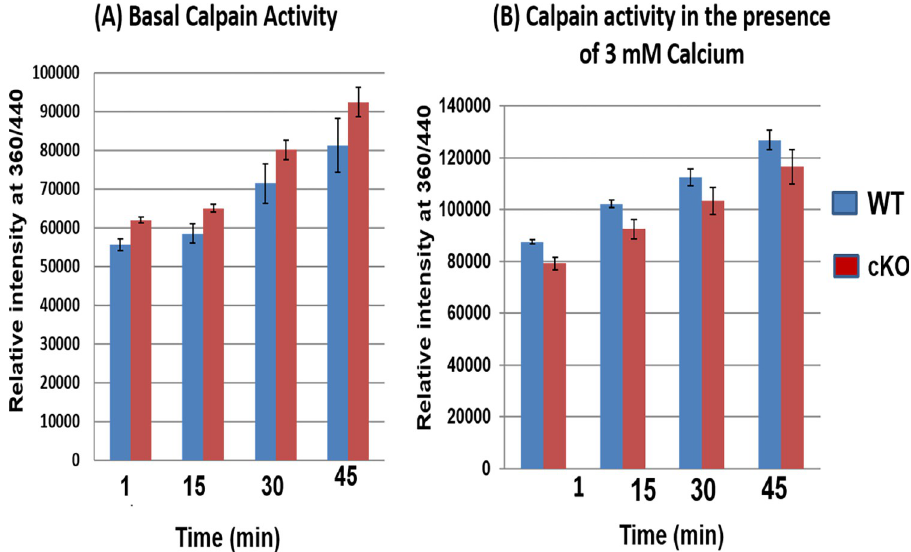
Interestingly, in addition to β -tubulin, fragments of calpain-3 were observed only in 5000 rpm spun-pellet fraction of cKO lenses but not in WT- and β A3HET-lenses Table 3. Earlier studies have shown that calpain being associated with cataract development. To further characterize calpain-3 activity in β A3cKO lenses, an in vitro calpain activity assay was carried out using N- total protein homogenates from 1-month-old WT- and β A3cKO-lenses were incubated with the substrate in the absence of calcium (representing the basal activity of calpain) and in the presence of 3 mM calcium (representing Ca 2+ -induced calpain activation), and the release of products was monitored at 15 min intervals up to 45 min. The β A3cKO lens homogenate exhibited a 10% increase in the basal calpain activity when compared under similar activities of the control lenses with increasing time (Fig 4A). However, despite 20% increase in calpain-3 activity in the presence of 3 mM Ca +2 by the β A3cKO lens homogenate relative to the basal cal- pain activity (Fig 4B) of the control lens homogenate, the calcium-induced activity was about